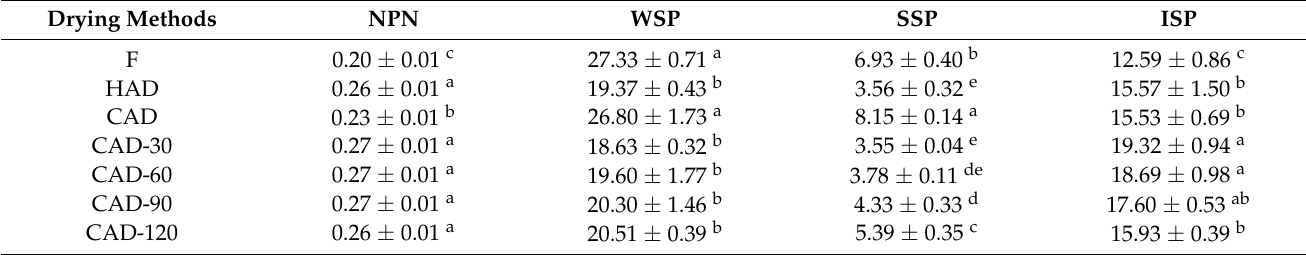
Table 2. Protein composition of pufferfish fillets under different drying methods